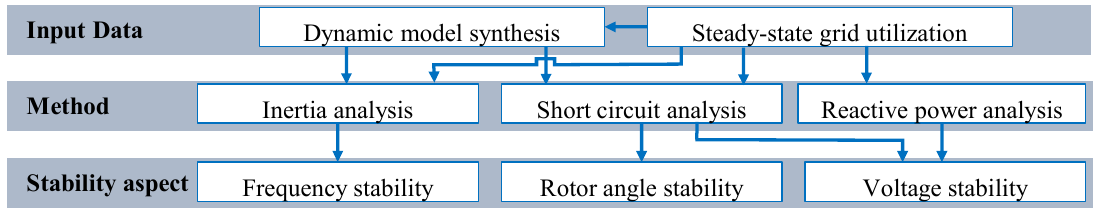
Figure 2. Overview of stability analyses.